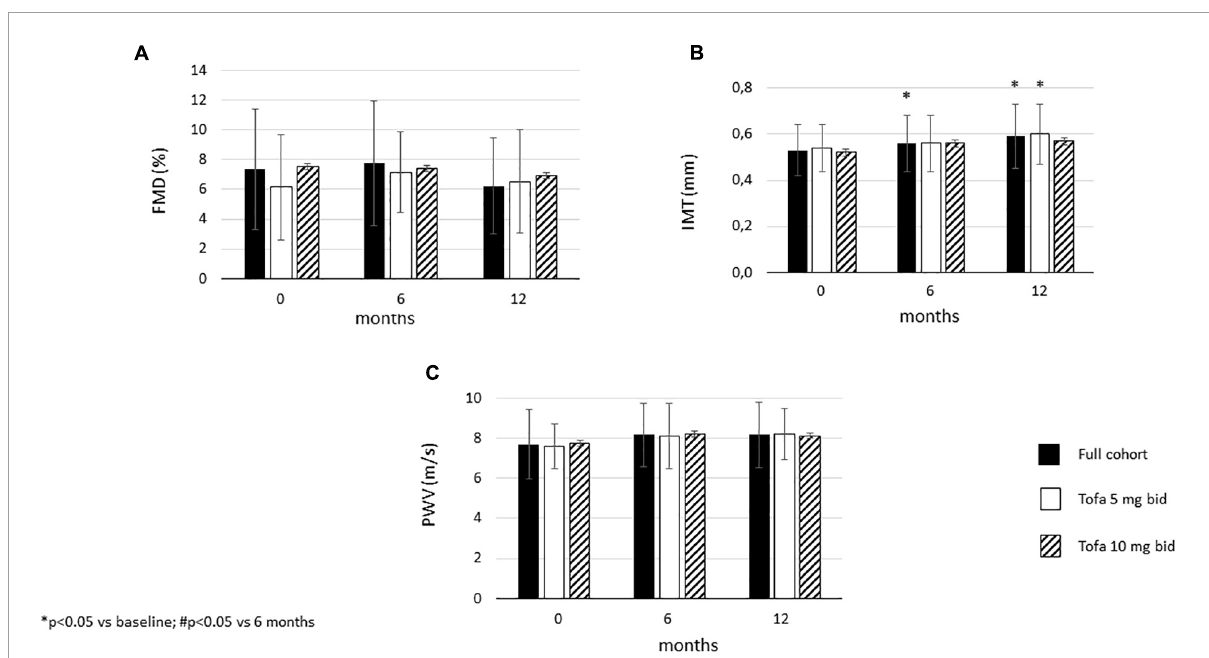
FIGURE3 Effects of one-year tofacitinib therapy on (A) flow-mediated vasodilation (FMD). (B) carotid intima-media thickness (IMT) and (C) arterial pulse-wave velocity (PWV). In the full cohort and in the 5 mg bid group there was a progression in IMT after 12 months. In contrast, 10 mg bid tofacitinib was able to halt IMT progression. Both doses of tofacitinib slowed down FMD and PWV